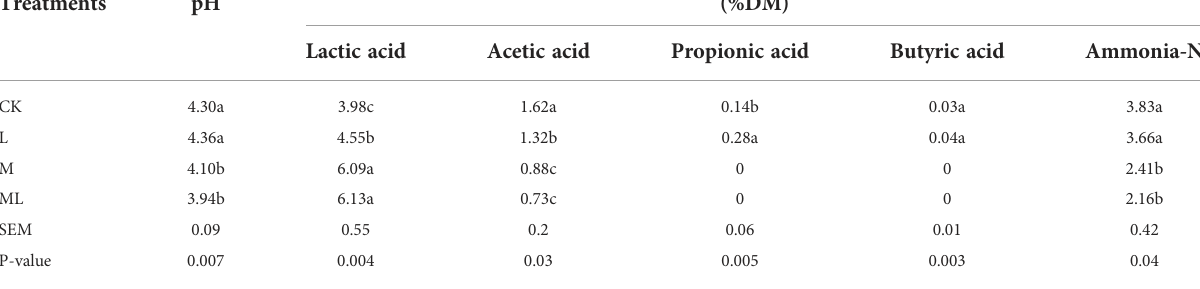
TABLE 2 Fermentation performance of mixed silage of KG and CF supplemented with L and M. (CK, control; L, lactic acid bacteria; M, molasses; ML, lactic acid bacteria + molasses).